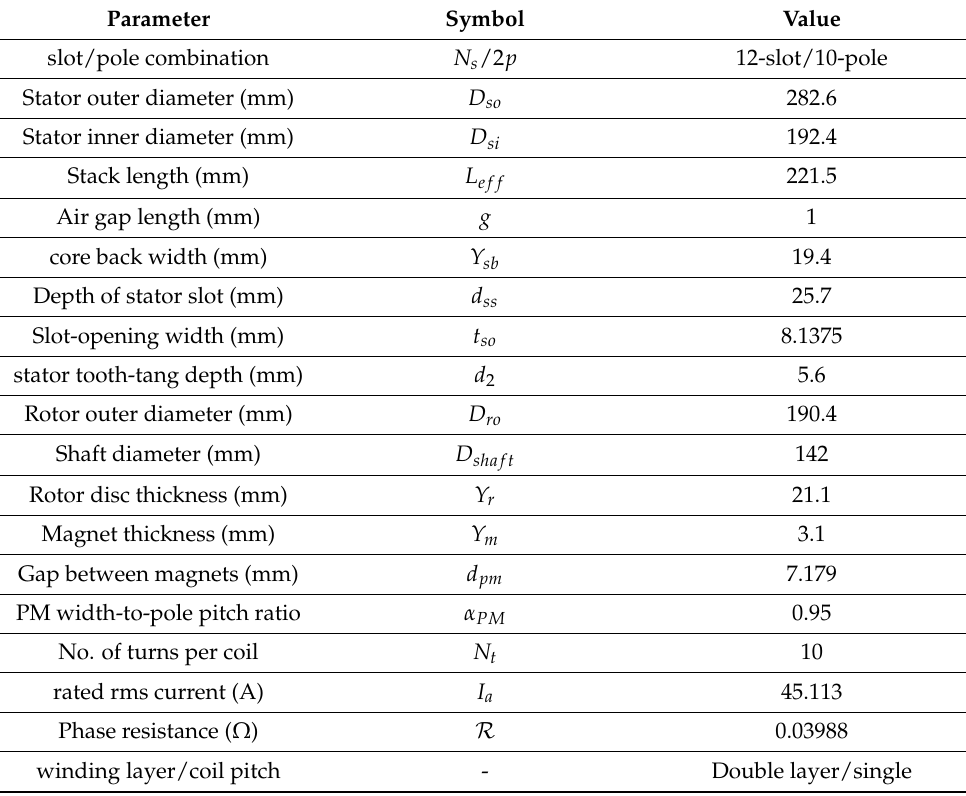
Figure 6. Pareto front between efficiency and power density. Table 3. SPM machines design